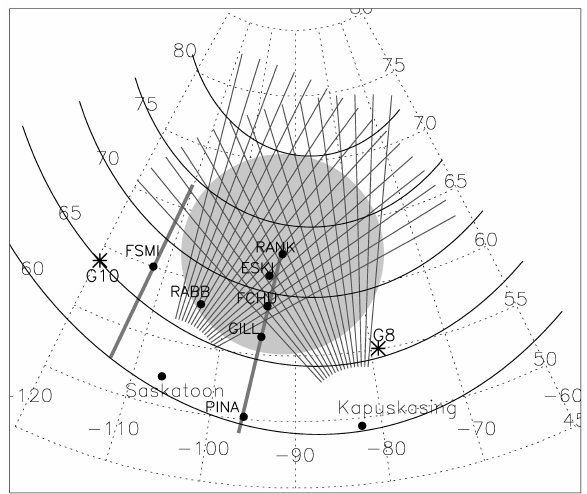
Fig. 1. Map of the FoVs of the SuperDARN radars at Saskatoon Figure 1 Map of the FoVs of the SuperDARN radars at Saskatoon and Kapuskasing, and of the and Kapuskasing, and of the NORSTAR imager at Rankin Inlet (for NORSTAR imager at Rankin Inlet (for red-line emission at assumed height of 215 km angles from 0 to red-line emission at assumed height of 215km angles from 0 to 80 ◦ from nadir). CANOPUS magnetometers listed in Table 1 are shown 80 0 from nadir). CANOPUS magnetometers listed in Table 1 are shown in black dots. The scan lines of in black dots. The scan lines of the Gillam and Fort Smith MSPs the Gillam and Fort Smith MSPs are shown in gray lines. The asterisks labeled G8 and G10 denote are shown in gray lines. The asterisks labeled G8 and G10 denote respectively the ionospheric footprints of the GOES-8 and GOES-10 satellites calculated from the T89c respectively the ionospheric footprints of the GOES-8 and GOES- 10 satellites calculated from the T89c model (Tsyganenko, 1989) model (Tsyganenko, 1989) with Kp=1. with K p =1.